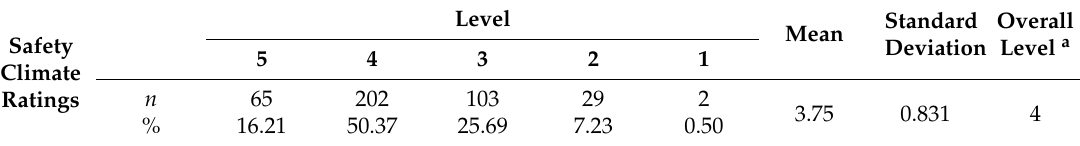
Table 6. Descriptive statistics of perceived overall safety climate ratings ( n =